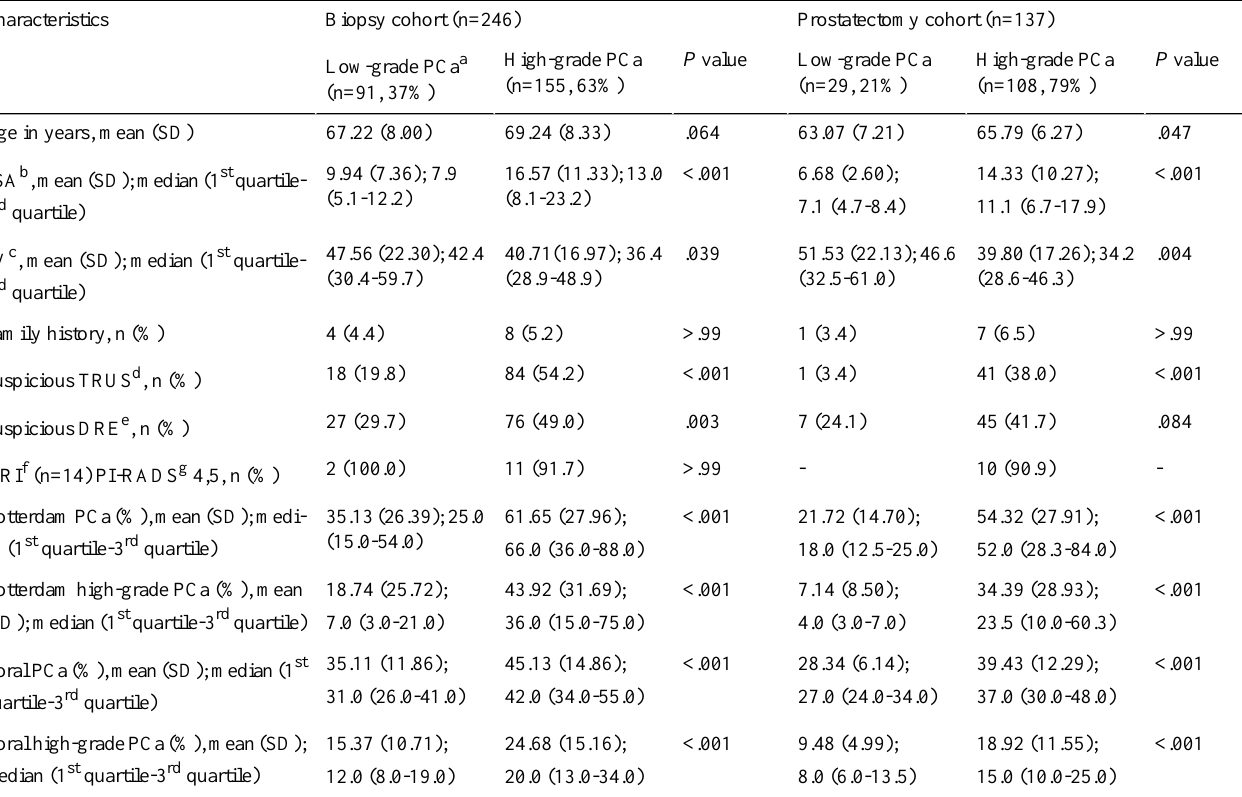
Table 2. Demographics of patients with prostate cancer (PCa; n=383). Categorical variables were assessed with the chi-square test; continuous variables were compared by the Mann-Whitney U test or the Student independent t test based on their nonnormal or normal distribution, respectively.